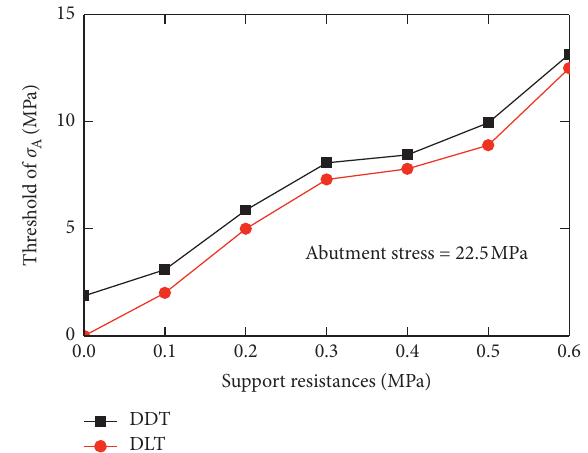
Figure 13: Effects of the support resistance on DDT and